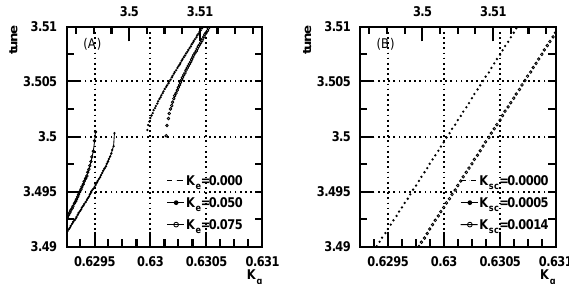
FIG. 7. Betatron tune in the presence of (A) gradient error field or (B) space-charge field.